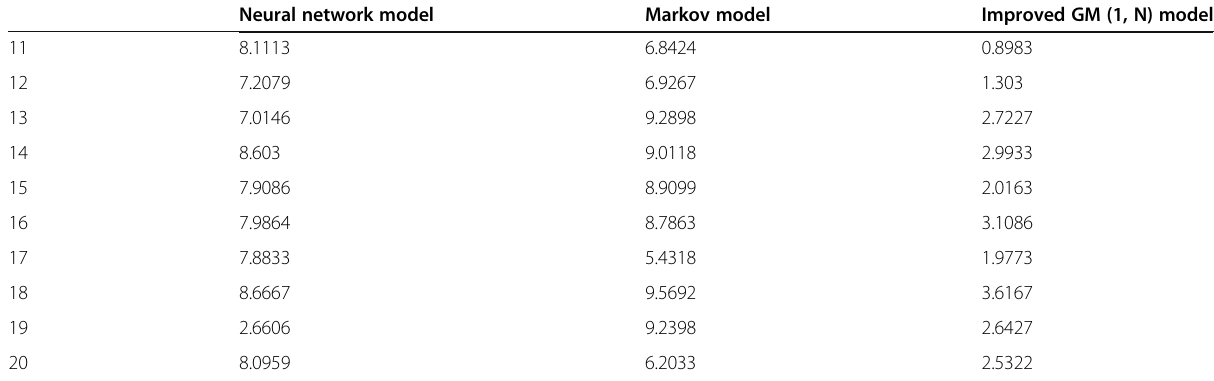
Table 2 Comparison of errors between errors Neural network model